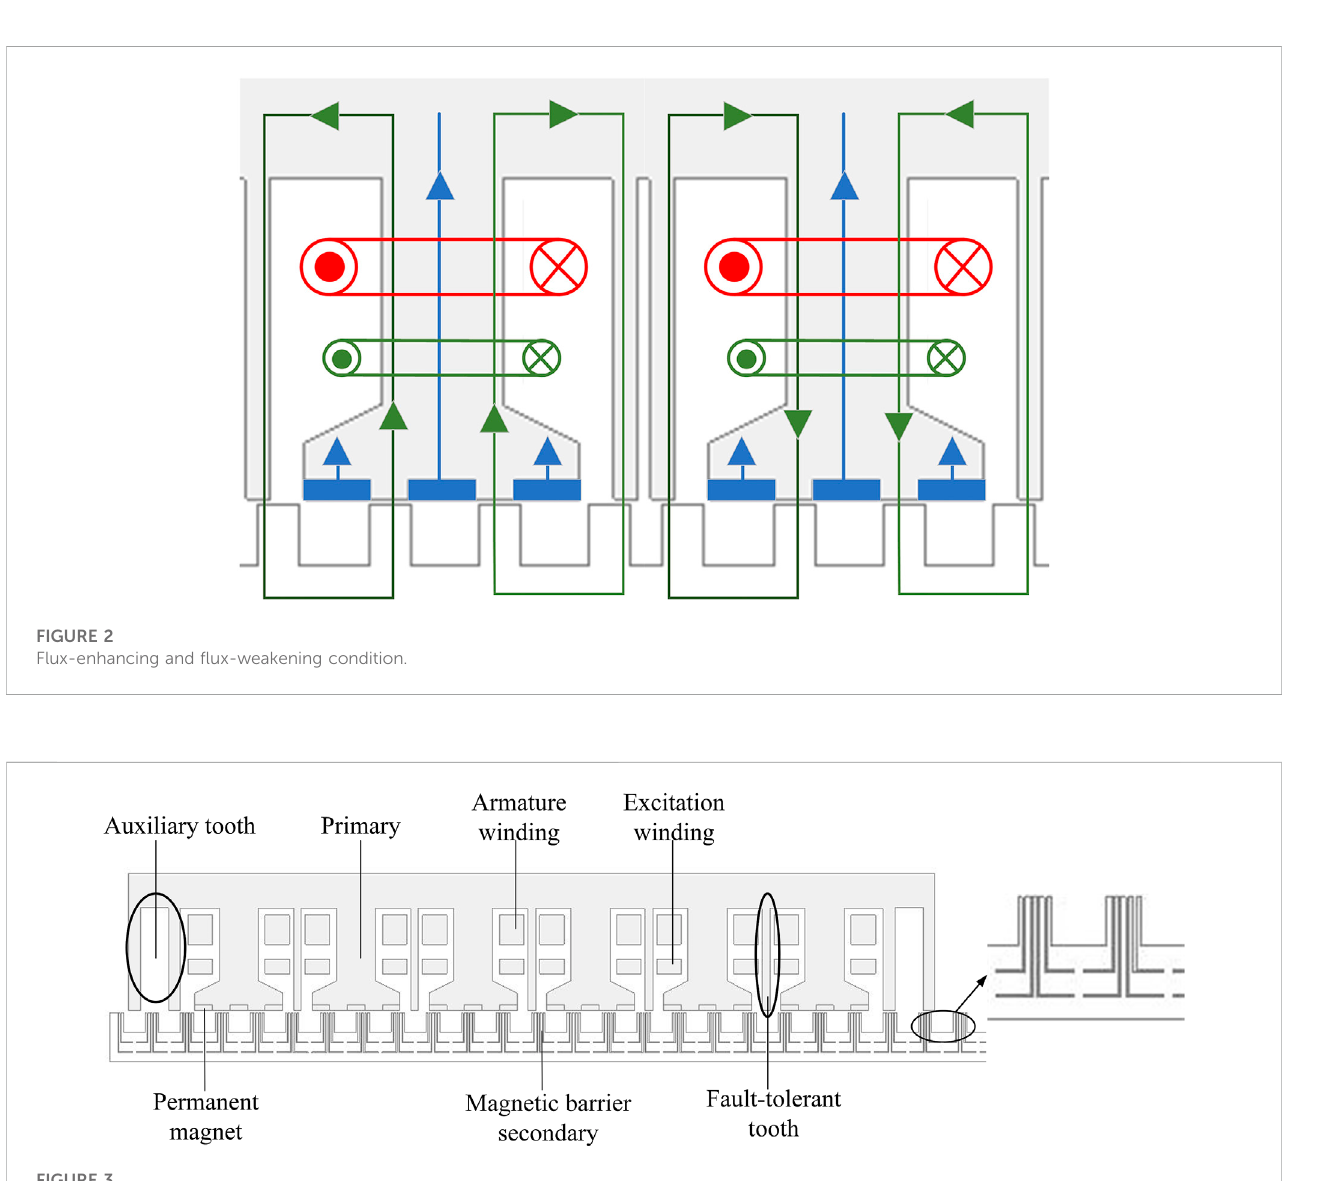
FIGURE 3 Topology of magnetic barrier